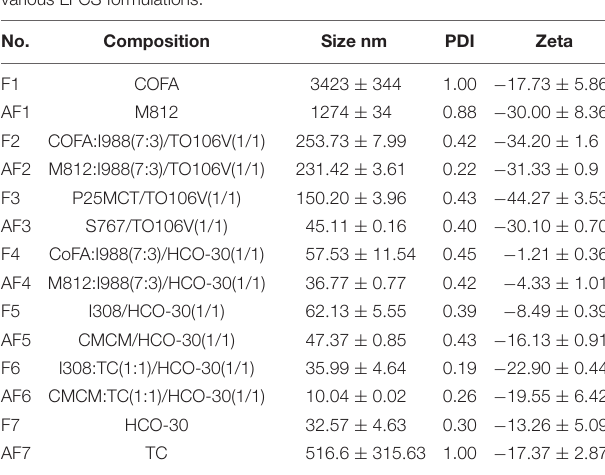
FIGURE 3 | The effect of hydrophilic compositions on the particle size and PDI of lipid based formulations (LBFs) for TAL. Formulations represent M812-Type I (AF1), M812:I988 (7:3)/TO106V (1/1)-Type II (AF2), M812:I988 (7:3)/HCO30(1/1)-Type IIIA (AF4), I308/HCO30(1/1)-Type IIIB (F5), I308:TC (1:1)/HCO30(1/1)-Type IIIB (F6), and HCO 30, Type IV (F7). Data are mean ± SD ( n = 3), Left Y-axis is presented in Log 10 scale.